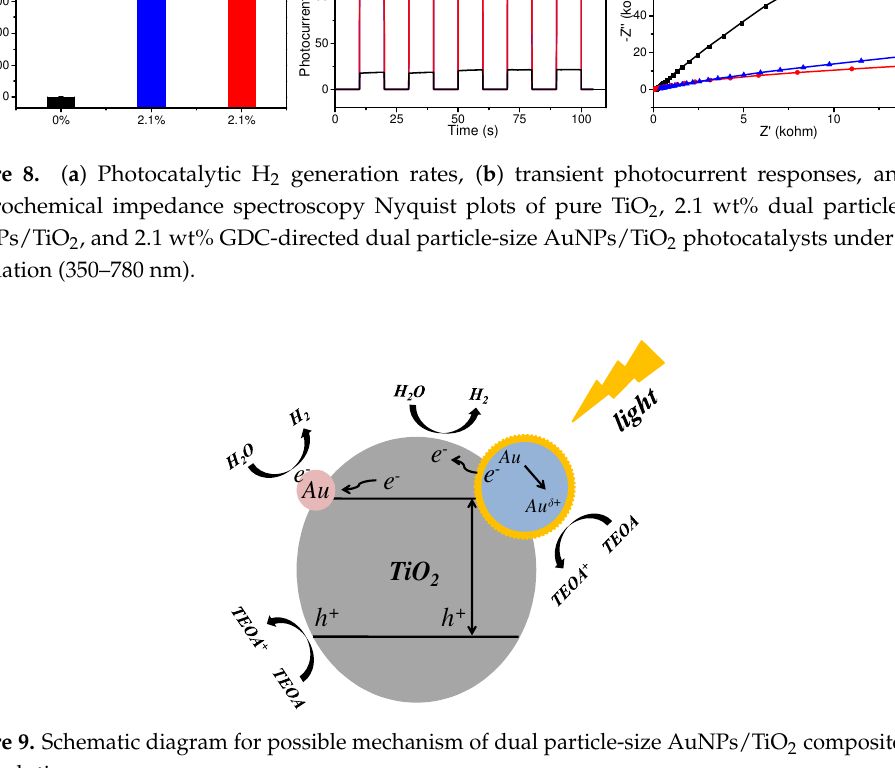
Figure 8. ( a ) Photocatalytic H 2 generation rates, ( b ) transient photocurrent responses, and ( c ) electrochemical impedance spectroscopy Nyquist plots of pure TiO 2 , 2.1 wt% dual particle-size